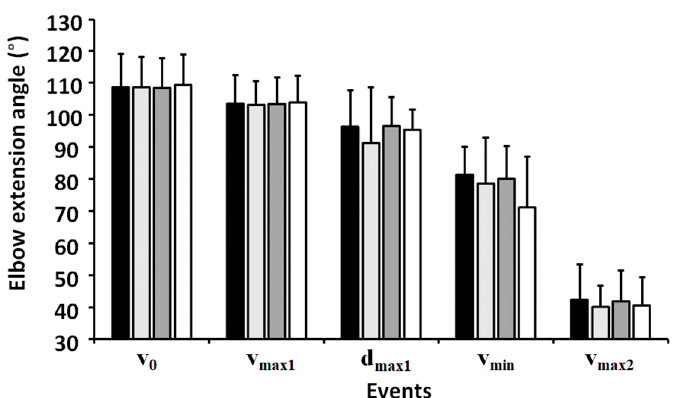
Figure 2. Mean ± SD shoulder abduction, shoulder flexion and elbow extension angle for the 1-RM, 3-RM, 6-RM, and 10-RM in the bench press for the events v 0 , v max1 , d max1 , v min and v max2 . The elbow and shoulder reached peak angular velocity elbow extension and shoulder flexion at approximately the first and second peak barbell velocity (Figure 3), and their velocity decreased between these points, with their minimal angular velocities concomitant with the event v min . Moreover, peak shoulder abduction velocity occurred only once. No significant effect of bench press condition was found for elbow extension velocity or shoulder abduction velocity (F ≤ 0.7, p ≥ 0.54, η p2 ≤ 0.08). However, a significant effect was found for shoulder flexion velocity (F = 5.07, p = 0.032, η p2 = 0.39). Post hoc tests revealed greater first shoulder peak velocity when benching with a 10-RM compared to the other bench press conditions (Figure 3).